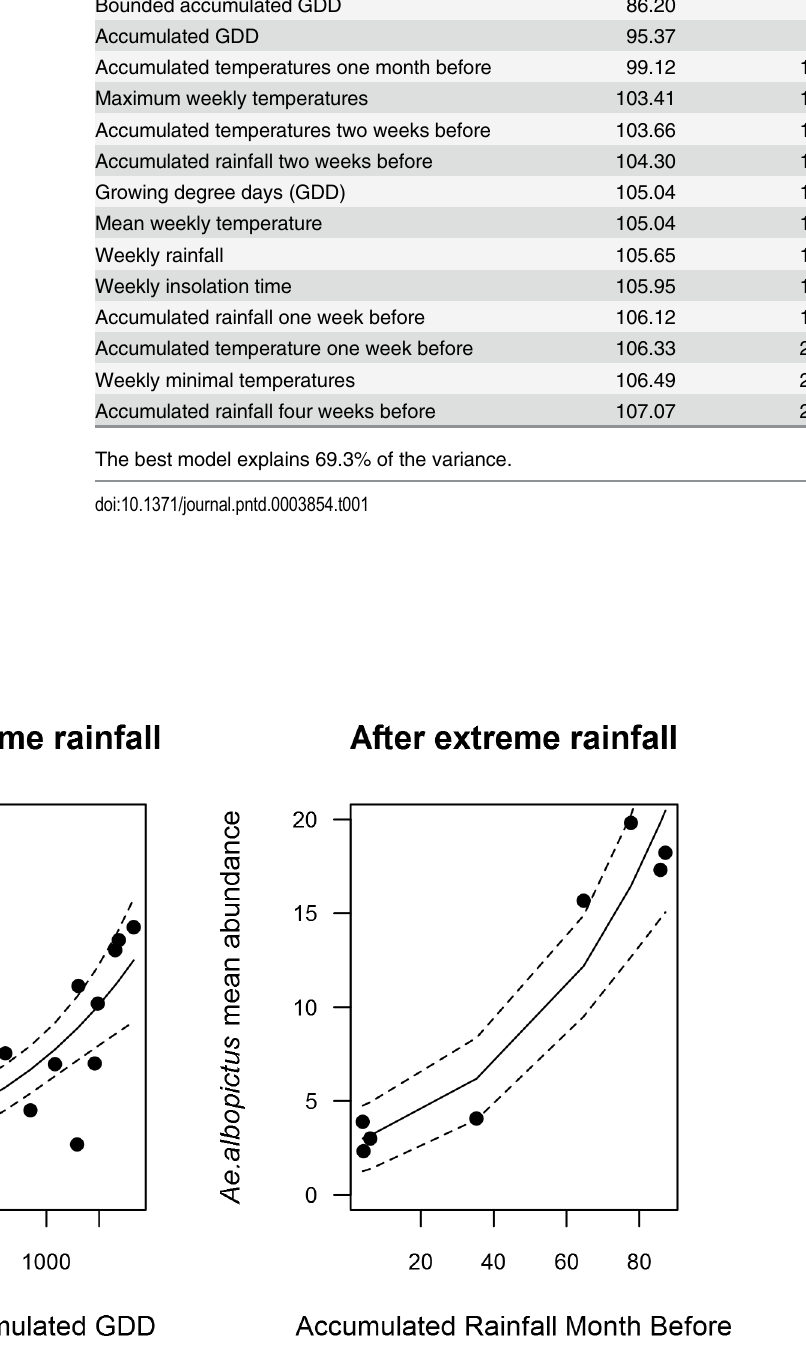
Fig 2. Results from the Generalized Linear Model with negative binomial distribution showing the impact of climatic variables on Ae . albopictus abundances before (left panel) and after (right panel) the extreme precipitation event in 2014. Before the inundations, weekly bounded accumulated Growing Degree Days were related to vector abundance. After the inundations, accumulated rainfall is more important than temperature (see also Table